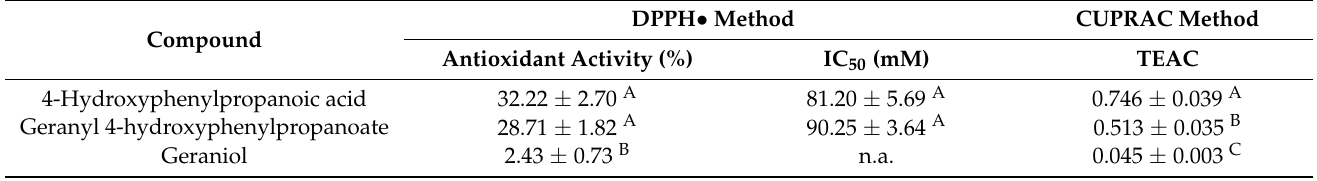
Table 4. Comparison of antioxidant activity of tested compounds by means of DPPH • and CUPRAC methods. Compound